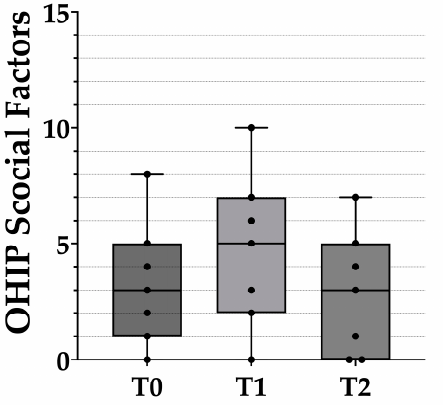
Figure 5. Box plots of the psychological impact scores from the OHIP-EDENT-J questionnaire. The black dots represent the distribution of raw data. T0: before the clinical remount. T1: immediately after the clinical remount. T2: 1 week after the clinical remount. Statistical analysis was performed with the Wilcoxon sign-rank test. Predetermined level of significance: p < 0.05.